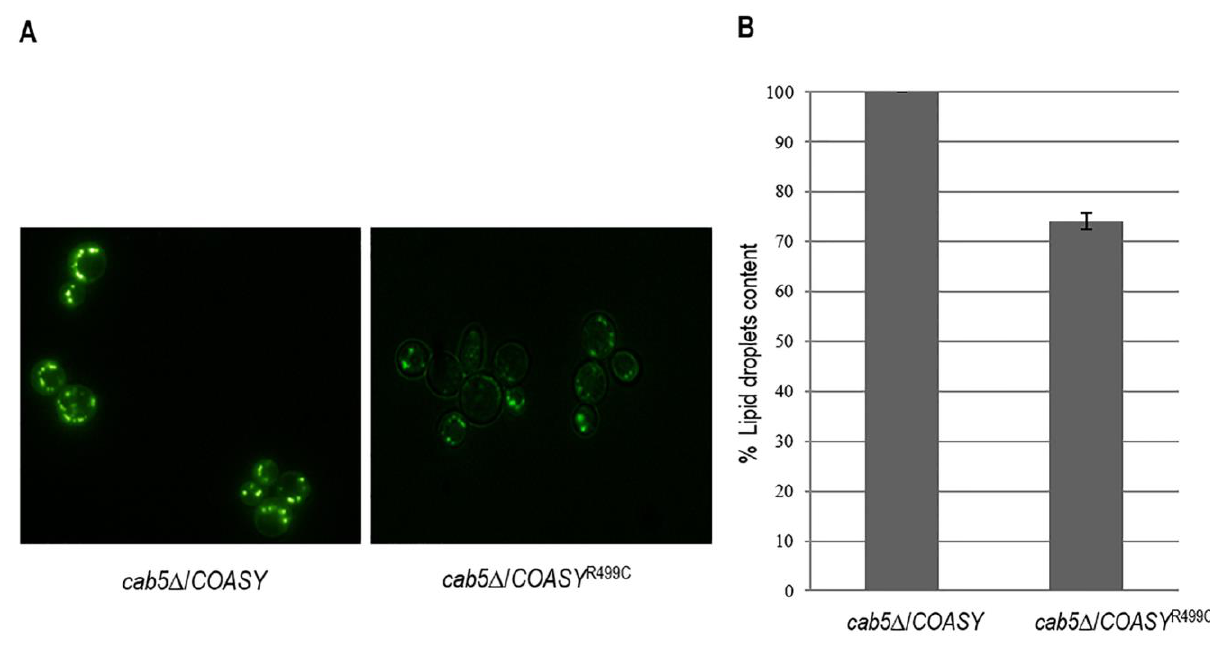
FIGURE 5: Evaluation of lipid droplets content. The intracellular lipid droplets content has been detected by fluorescence microscopy (A) and fluorimetric analysis (B) after incubation of wild type and mutant cells with the fluorescent lipophilic dye Nile Red (4 μ g/ml). The values corresponding to mutant COASY are expressed as percentage of the content obtained in the wild type